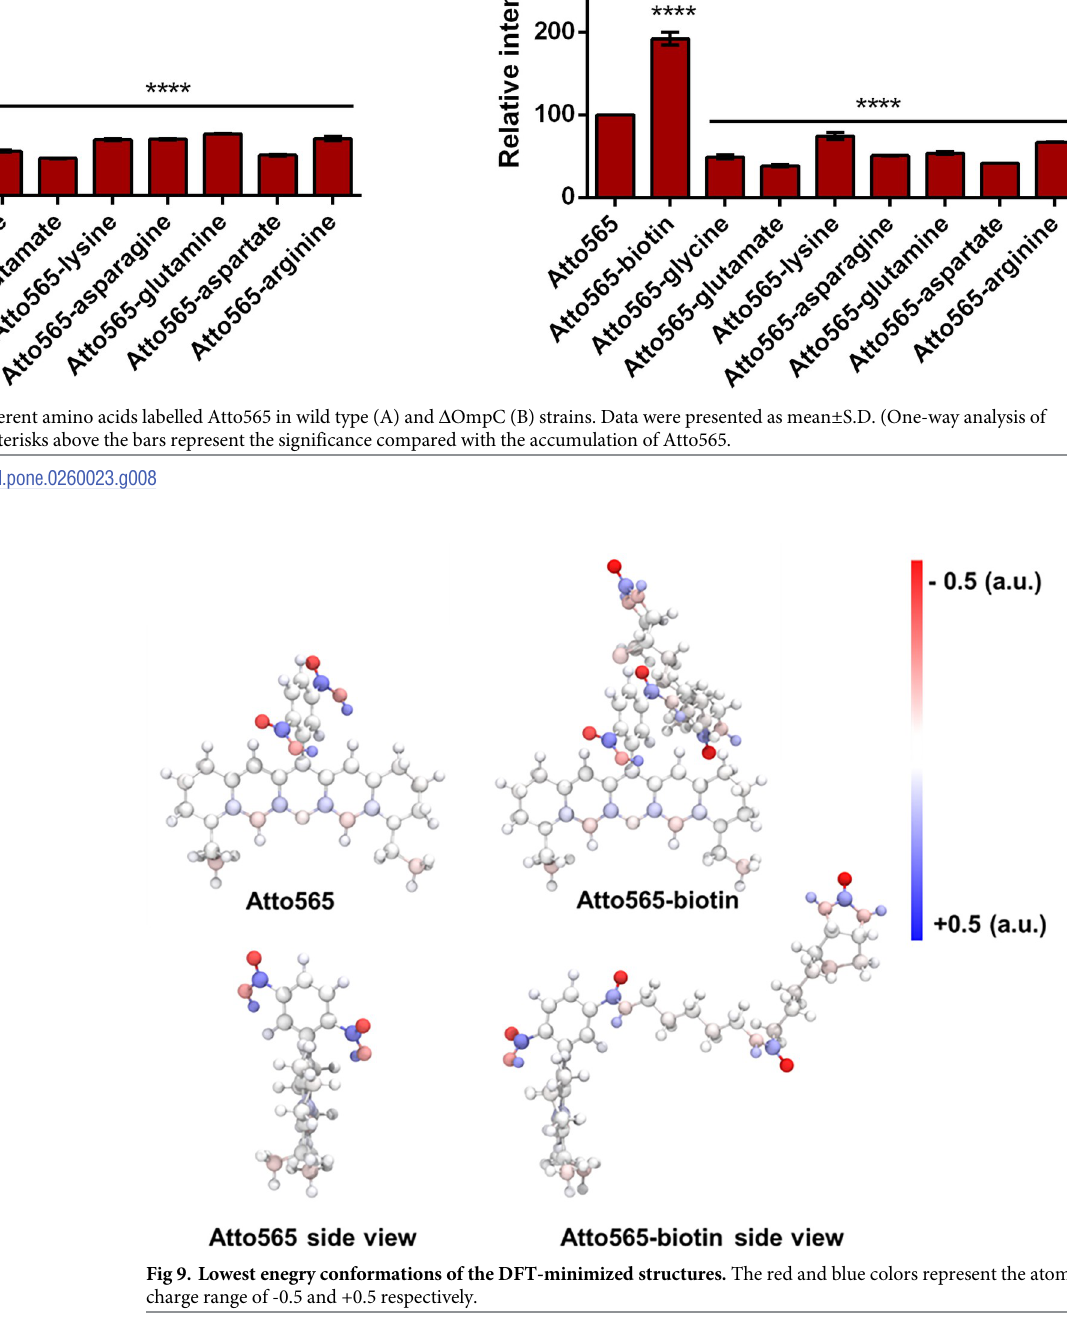
PLOS ONE | https://doi.org/10.1371/journal.pone.0260023 November12, 2021 14 /